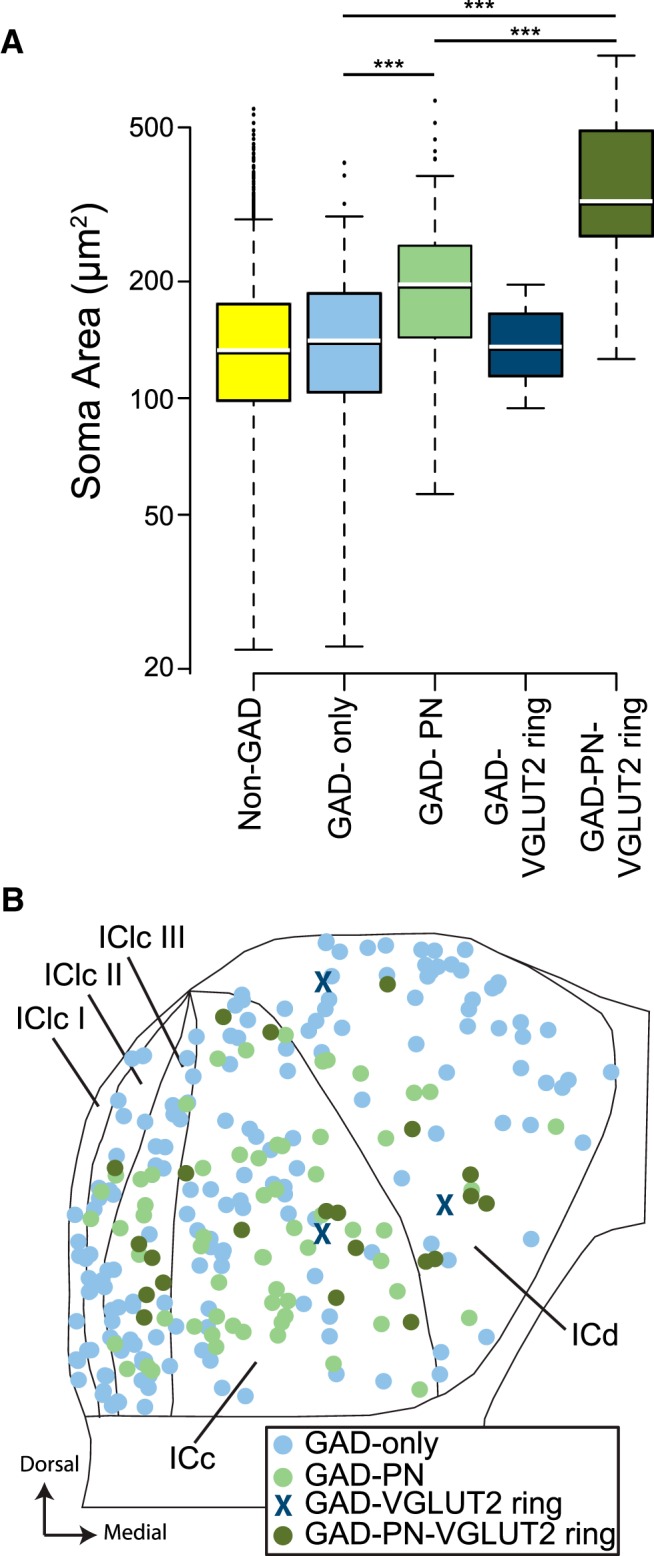
The four subtypes of GABAergic neurons in the IC–MG projection differ in soma size and spatial distribution. A, Box and whisker plot showing the range and median soma profile areas of non-GAD (yellow), GAD-only (light blue), GAD-PN (light green), GAD-VGLUT2 ring (dark blue), and GAD-PN-VGLUT2 ring (dark green) IC–MG cells. On average, GAD-only cell somas are smaller than GAD-PN cell somas, and GAD-PN-VGLUT2 ring cells have the largest somas. Note that the y-axis of the box plot is logarithmically scaled. Sample sizes: non-GAD = 4024 cells; GAD-only = 170 cells; GAD-VGLUT2 ring = 3 cells; GAD-PN = 63 cells; GAD-PN-VGLUT2 ring = 22 cells. Three asterisks indicate a significant difference in soma size between two groups at the p = 0.001 level. B, Composite plot of all the GAD+ IC–MG projecting cells in this study (cells from two sections each from 6 cases). Light blue markers indicate GAD-only cells, dark blue X’s indicate GAD-VGLUT2 ring cells, light green markers indicate GAD-PN cells, and dark green markers indicate GAD-PN-VGLUT2 ring cells. GAD-only cells are relatively more dense along the lateral and dorsal edges of the IC, whereas GAD+ cells surrounded by PNs and/or VGLUT2 rings are relatively more dense in deeper regions of the IC (ICc and IClc layer III). ICc- central nucleus of the IC; ICd- dorsal cortex of the IC, IClc I, II, and III, Layers I, II, and III of the lateral cortex of the IC.